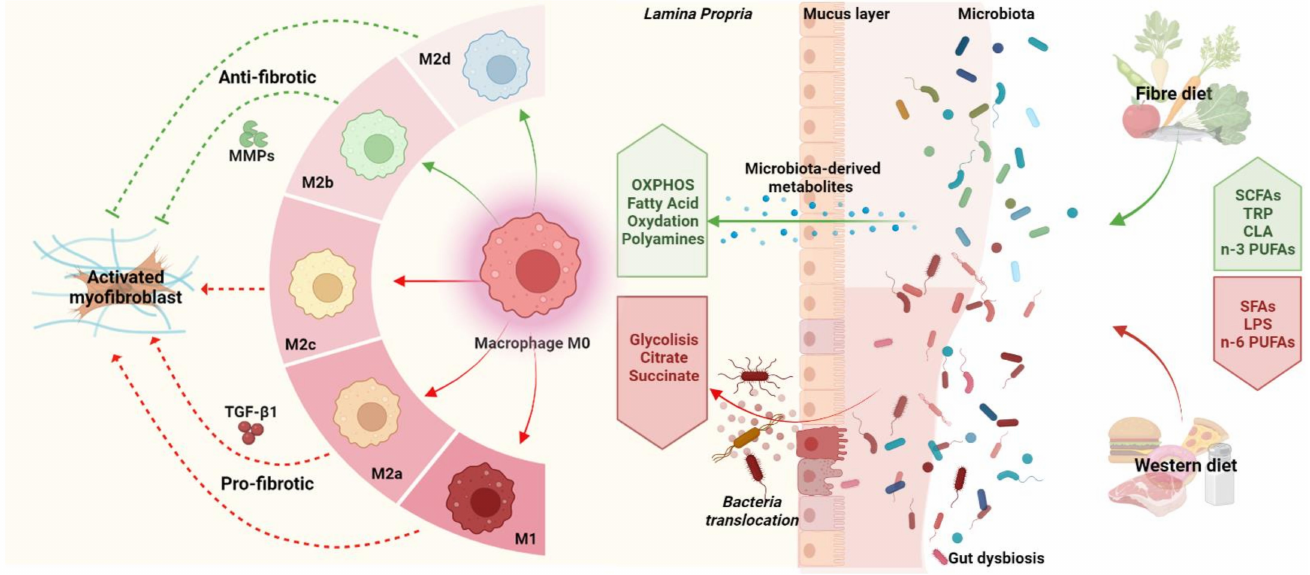
Figure 2. Interplay between diet, gut microbiota, and macrophages during intestinal fibrosis. The gut microbiota regulates intestinal macrophage phenotypes and functions by releasing specific metabolites derived from the metabolism of dietary components. Dietary fibre (green pathway) is metabolised by gut microbiota, leading to short chain fatty acid (SCFA) production, which in turn promotes M2b and M2d macrophage polarisation, which is characterised by an increase of lipid oxidation, providing sustained energy for macrophage anti-fibrotic functions. Dietary components can exert detrimental effects, activating pro-inflammatory and pro-fibrotic processes. The western diet (red pathway), characterised by high fat, high sugar and high salt contents, alters gut microbiota composition (dysbiosis), impairs the gut barrier and leads to n-3 polyunsaturated fatty acid (n-3 PUFA), saturated fatty acid (SFA), and lipopolysaccharide (LPS) production. In turn, macrophages undergo a metabolic reprogramming towards glycolysis and assume an M1, M2a, or M2c phenotype, leading to myofibroblast activation, producing ECM through TGF- β 1